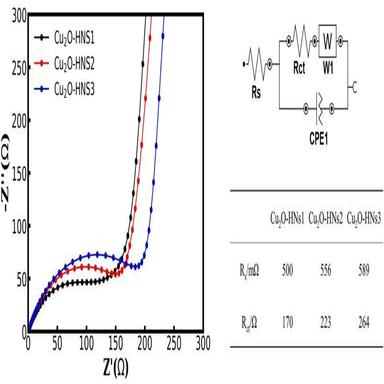
Nyquist plots of Cu2O-HNs half-cells and the corresponding equivalent circuit model.